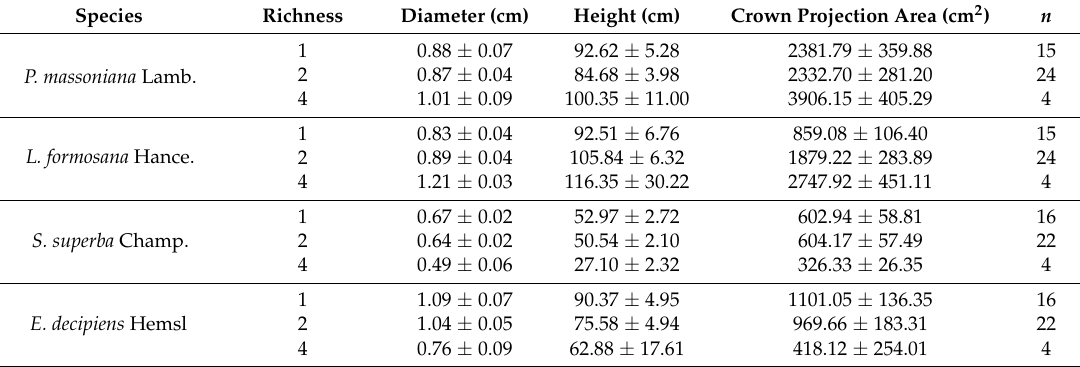
Table 1. The mean diameter, height, crown projection area, and number of saplings in different species diversity levels at the end the pot experiment. Given are means ± SE (standard error).